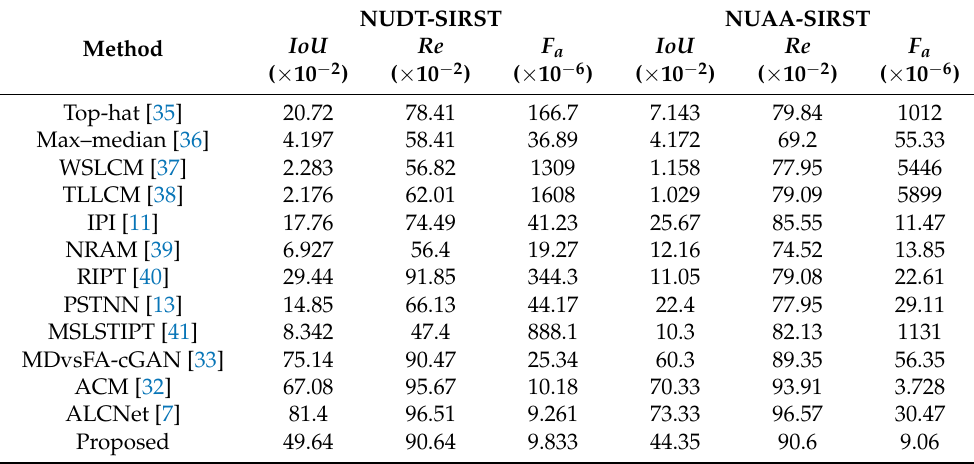
Table 5. IoU , Re , and F a values achieved on the NUDT-SIRST and NUAA-SIRST datasets.